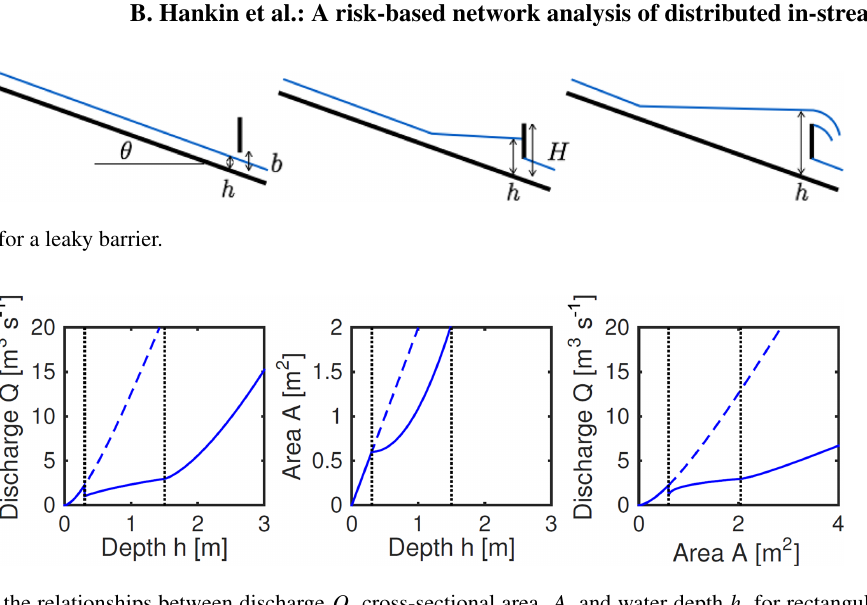
Figure 4. Examples of the relationships between discharge Q , cross-sectional area, A , and water depth h , for rectangular channel of width w = 2m, slope S = 0 . 01, reach length l = 100m and Manning’s n of 0.01. Dashed lines show the case of no dam. Solid lines show cases of b = 0 . 3m; H = 1 . 5m is shown by the vertical dotted